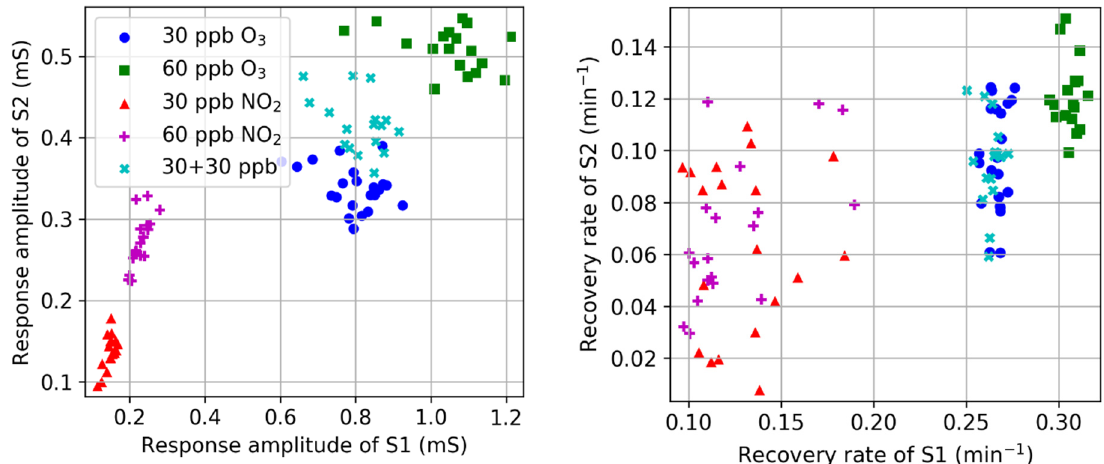
Figure 7. Clustering of the data points in 2D feature space of the response amplitudes ( left ) or the recovery rates ( right ) of sensors S1 and S2.